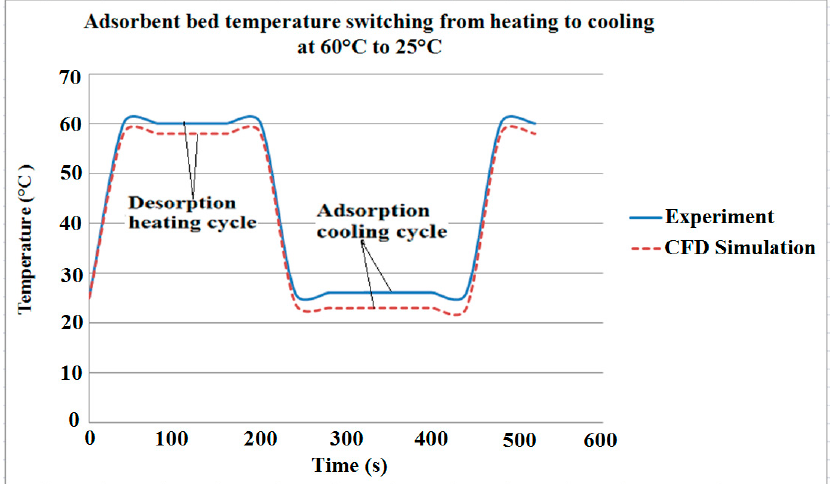
Figure 10. Comparison of the outlet temperature of the CFD simulation and the experiment data by J. White ©2012 [10].